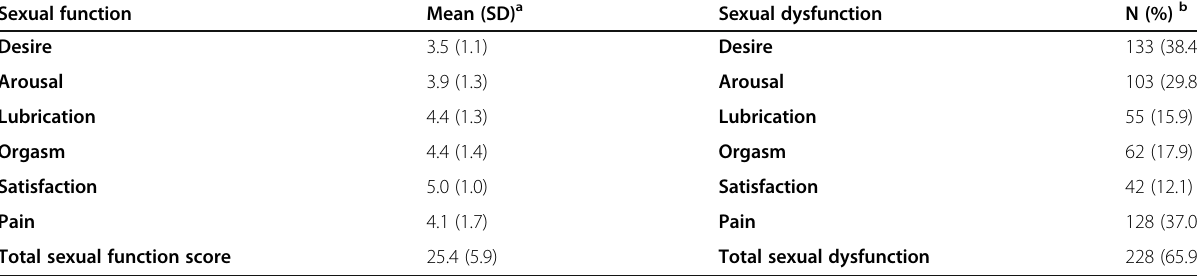
Possible range scores for all domains are 0 – 6 except for the desire which it is 1.2 – 6 and for the total function is 2 – 36, higher scores show better sexual function. The cut-off points for sub domain and sexual dysfunction were as follows: sexual desire ≤ 3.3, sexual arousal ≤ 3.4, lubrication ≤ 3.4, sexual pain ≤ 3.8, orgasm ≤ 3.4,